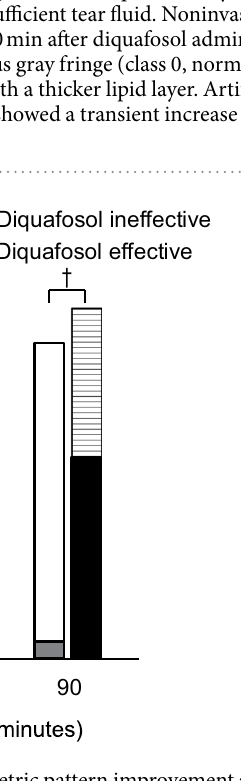
Figure 5. Time course of interferometric pattern improvement after artificial tear or diquafosol administration. Eyes of interferometric class 2 (evaporative dry eye type) before administration were categorized as showing an improvement (that is, treatment was effective) if the interference pattern changed to class 0 (normal type) or class 1 (aqueous-deficient dry eye type). The numbers of eyes of class 2 before administration were 36 and 40 out of 47 in the control group and the diquafosol group, respectively. † P < 0.001 versus the control group at each assessment time point (Fisher’s exact